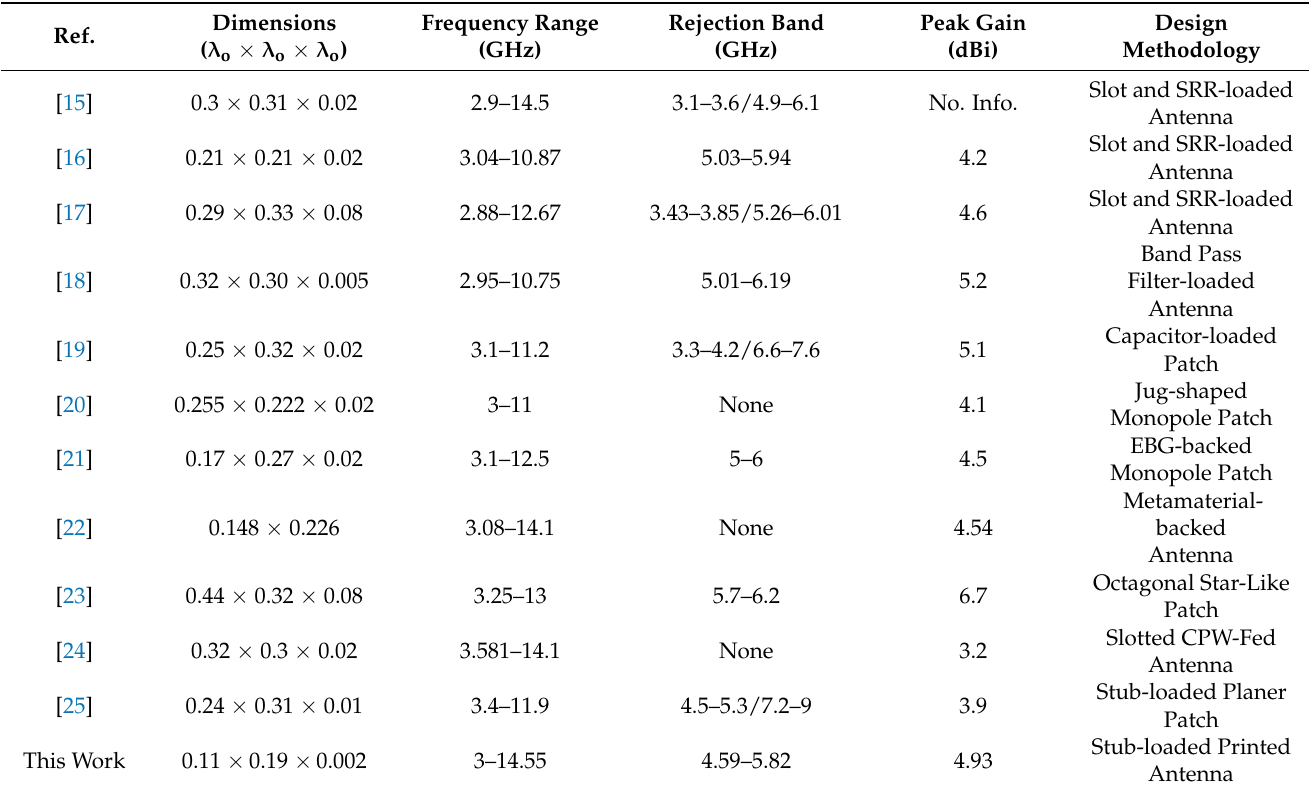
Table 1. Performance comparison of the proposed antenna with existing UWB antennas in the literature.